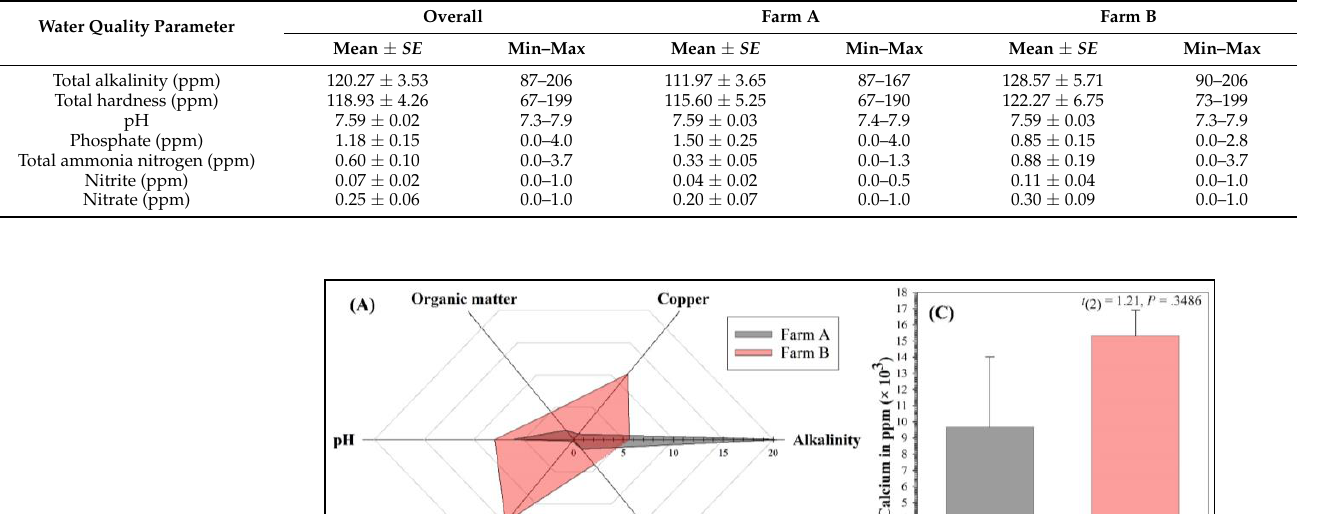
Table 2. Water quality parameters (mean, standard error ( SE ), minimum measurement (min), and maximum measurement (max)) measured in 12 study tanks containing sediment samples (2 farms; 2 ponds per farm; 3 replicate tanks per pond) for 28 d.